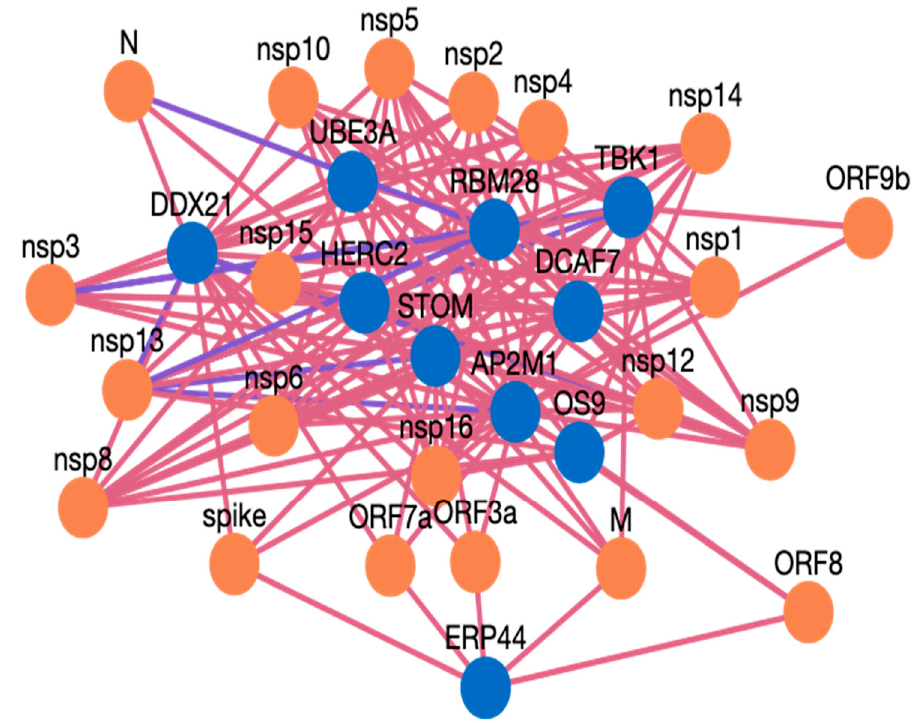
Figure 3. A snapshot of the results page of HuCoPIA.